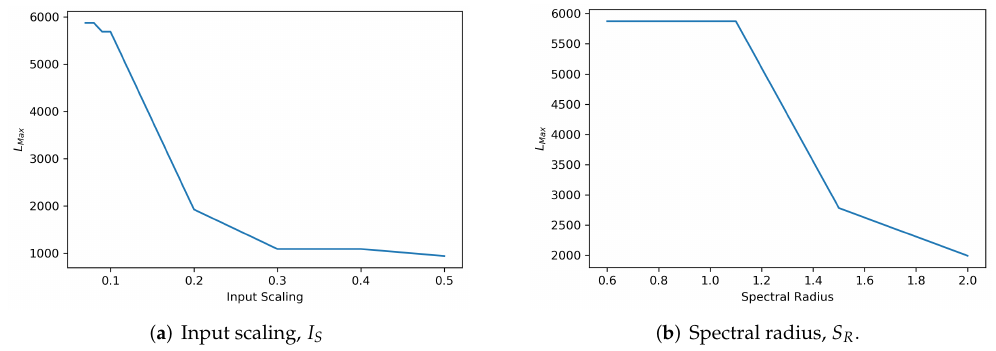
Figure 9. Results on the Florence3D dataset. Measured reservoir stability, L MAX against different hyperparameter